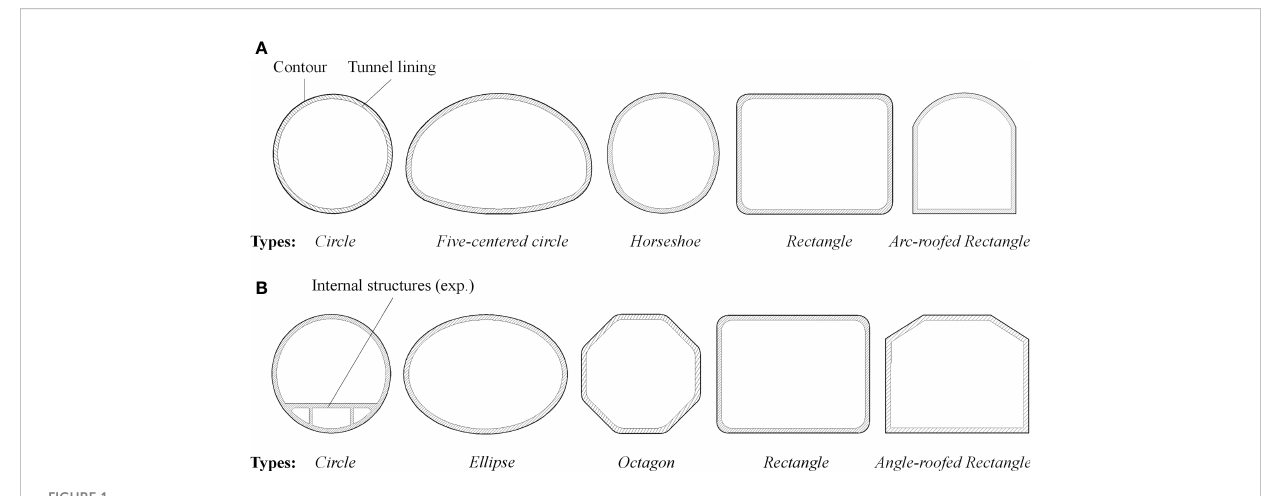
FIGURE 1 Typical cross-section types of land tunnels (A) and undersea tunnels (B)